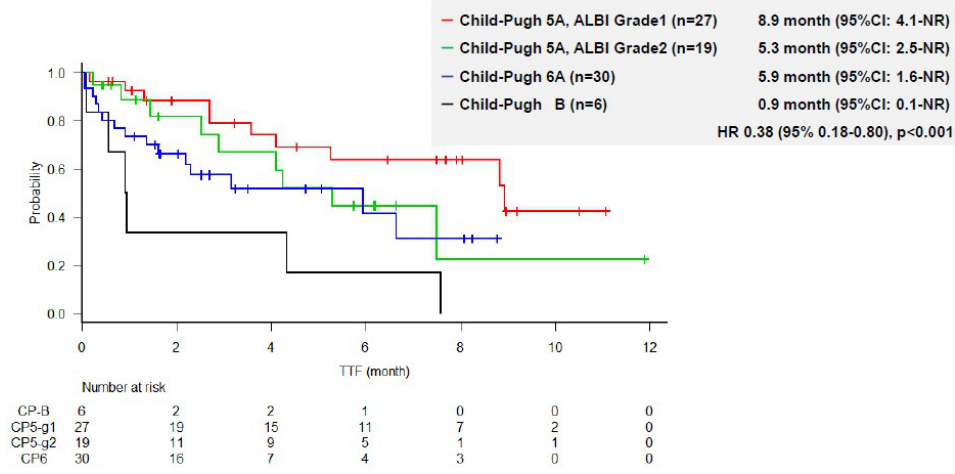
Figure 1. Time to treatment failure according to liver function.